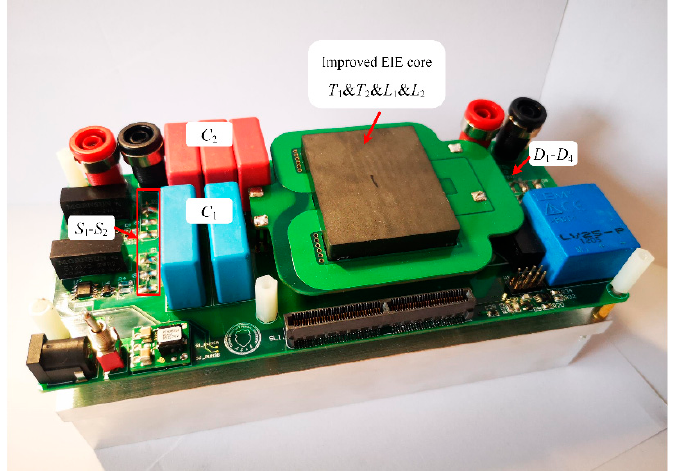
Figure 13. Proposed E-type core and I-type core. Table 1. Comparison between the improved EIE (E-type and I-type and E-type) core structure and discrete magnetics.